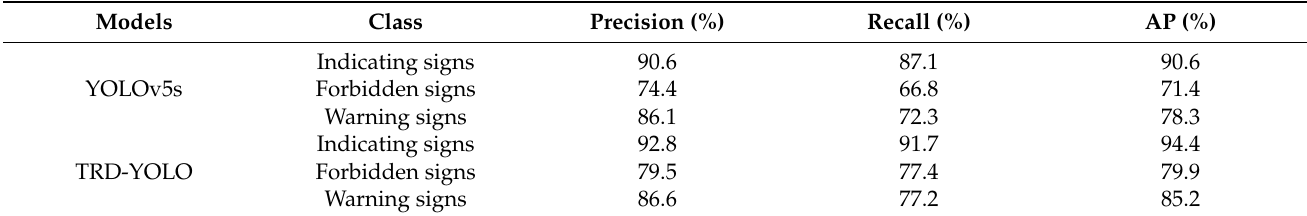
Table 3. Comparison of different types of traffic